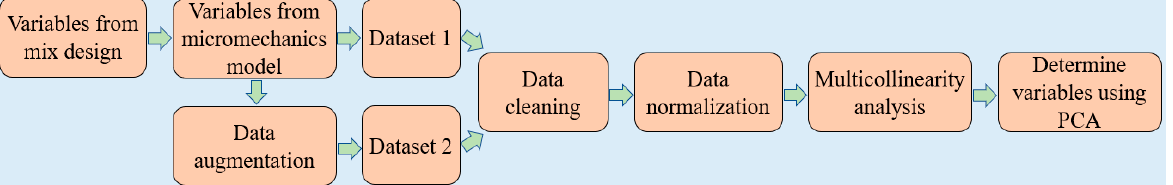
Figure 2. Flowchart of the proposed method for the selection and improvement of the variables.